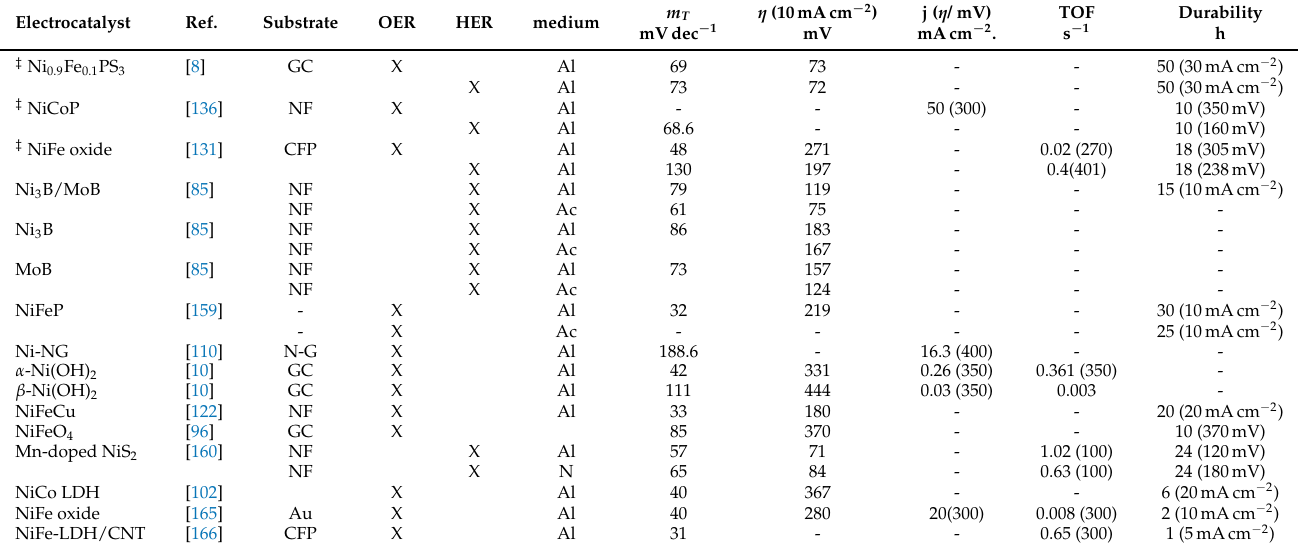
Table 4. Performance parameters of nickel-based electrocatalysts for OER and